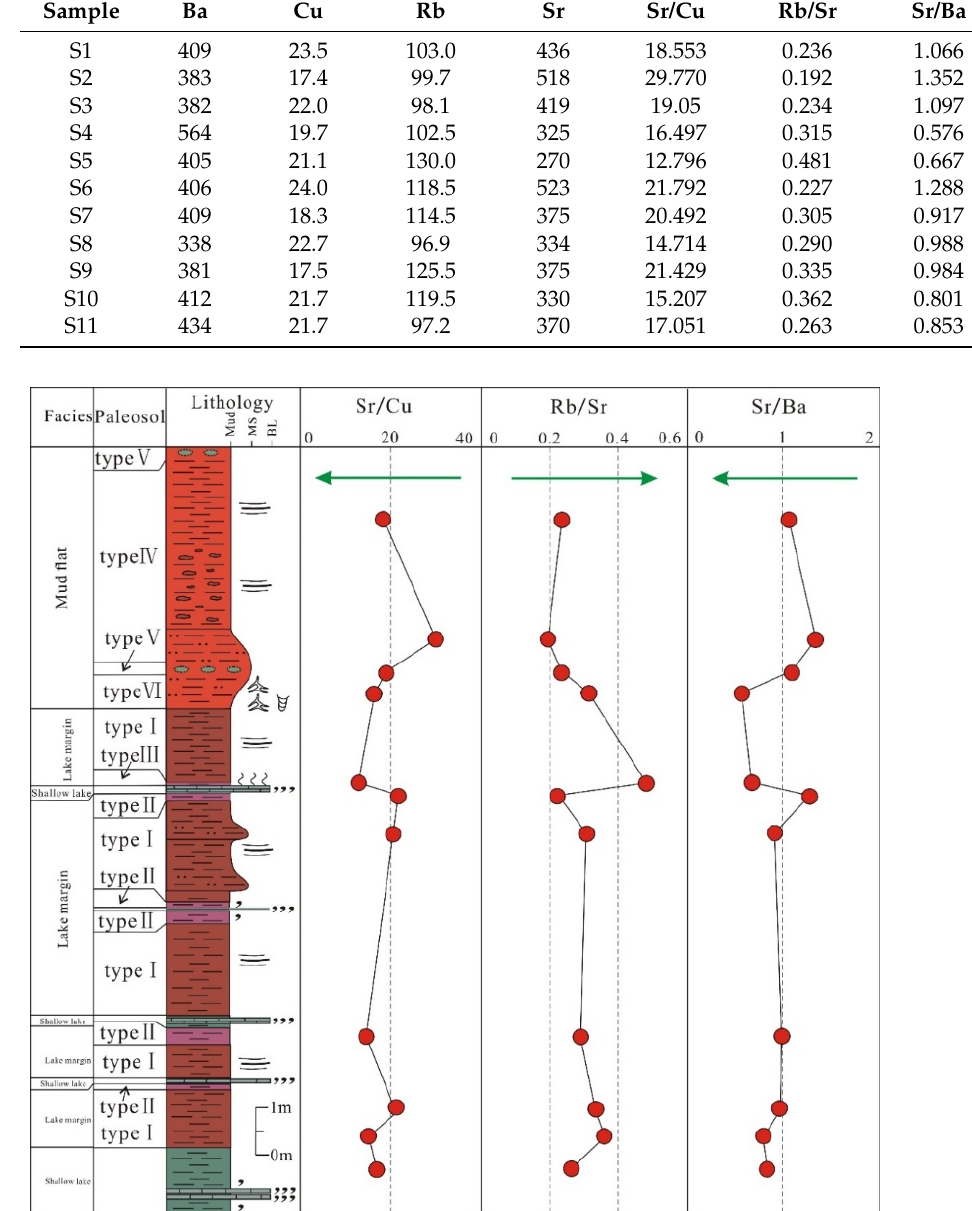
Figure 7. Vertical variations of values of trace elements and elemental geochemical parameters in the measured section of the Yaojia Formation. The variation of relative lake level is interpreted from the sedimentary facies. See Figure 2 for the symbols.